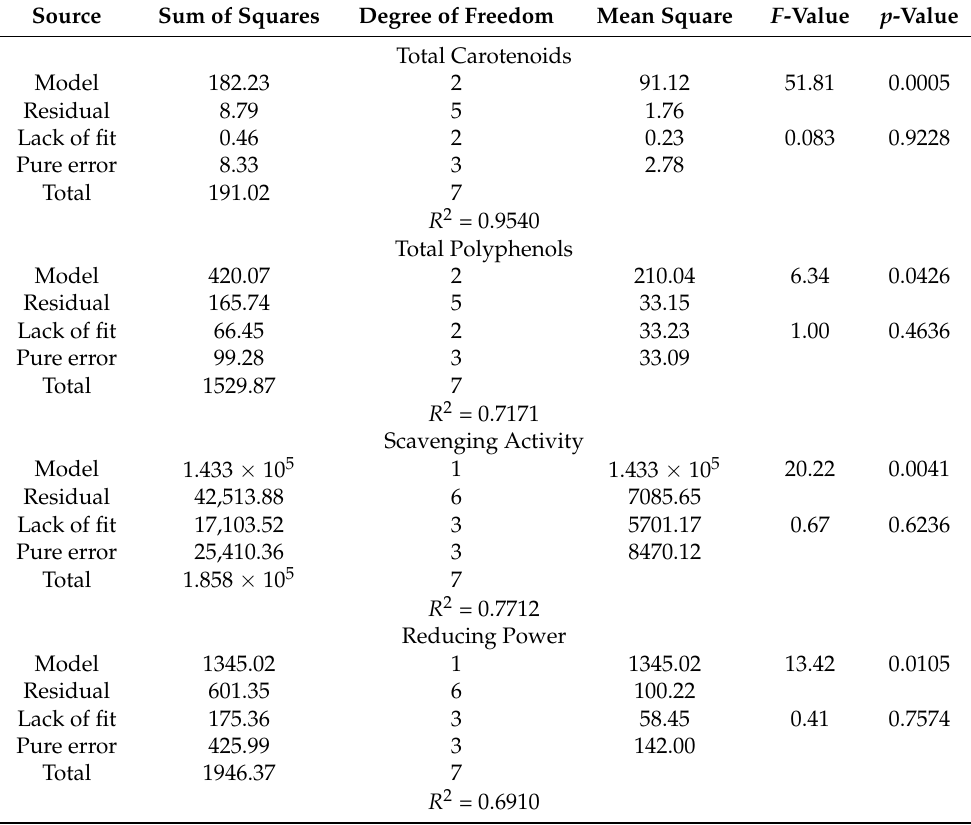
Table 4. Analysis of variance (ANOVA) of the modelled responses for ethanol + acetone + 20%